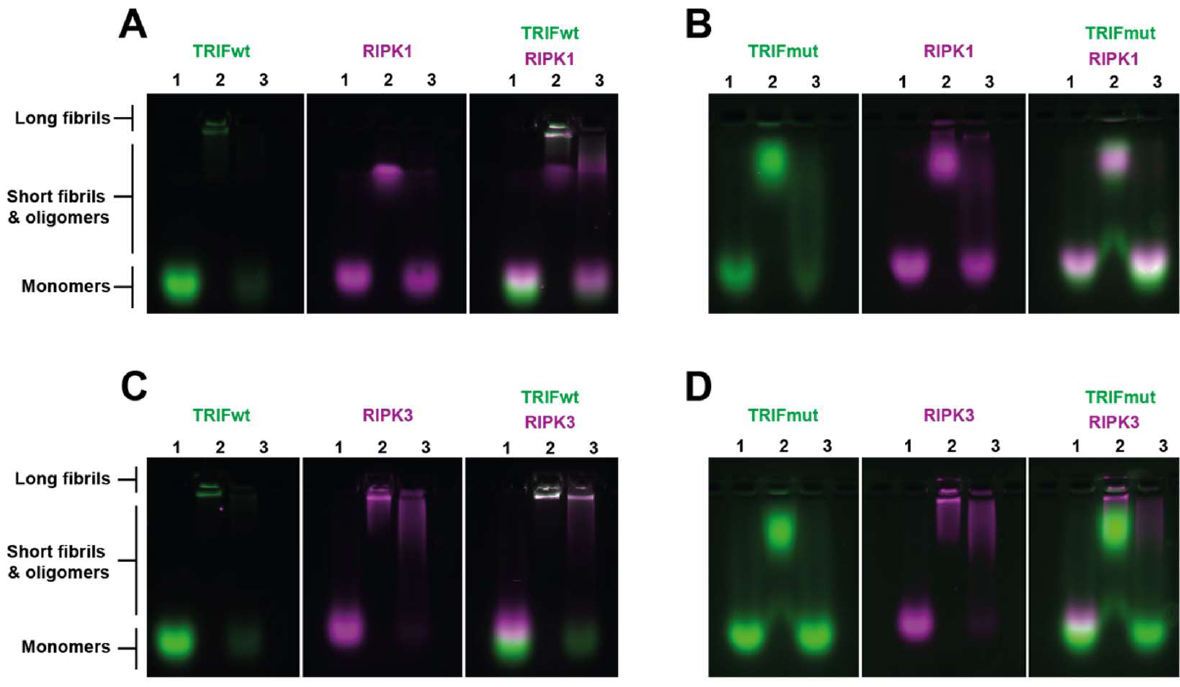
Figure 5. SDS-agarose gel electrophoresis reveals structural properties arising from heteromeric assembly of TRIF and other RHIM-containing proteins. Single or equimolar at 5 µM two-protein combinations carrying YPet or mCherry fluorophores were prepared in (1) monomeric or (2) co-assembled forms and (3) treated with SDS, then electrophoresed on an agarose gel and imaged. Protein combinations used: ( A ) YPet-TRIF 601–712 and mCherry-RIPK1 497–583 , ( B ) YPet-TRIFmut 601–712 and mCherry-RIPK1 497–583 , ( C ) YPet-TRIF 601–712 and mCherry-RIPK3 387–518, ( D ) YPet-TRIFmut 601–712 and mCherry-RIPK3 387–518 . All conditions were imaged with both GFP and mCherry appropriate filter sets, and then overlaid using FIJI ImageJ. All experiments were conducted multiple times, and a representative gel is shown. Migration of long fibrils, short fibrils/oligomers and monomeric forms are indicated.